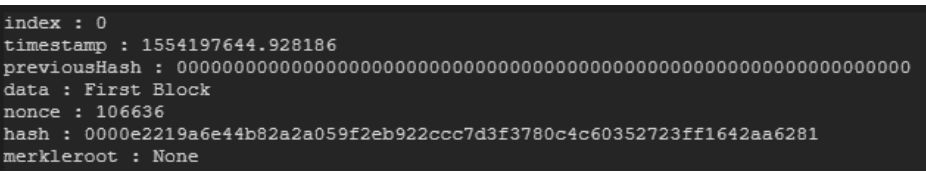
Figure 15. Upload of encrypted